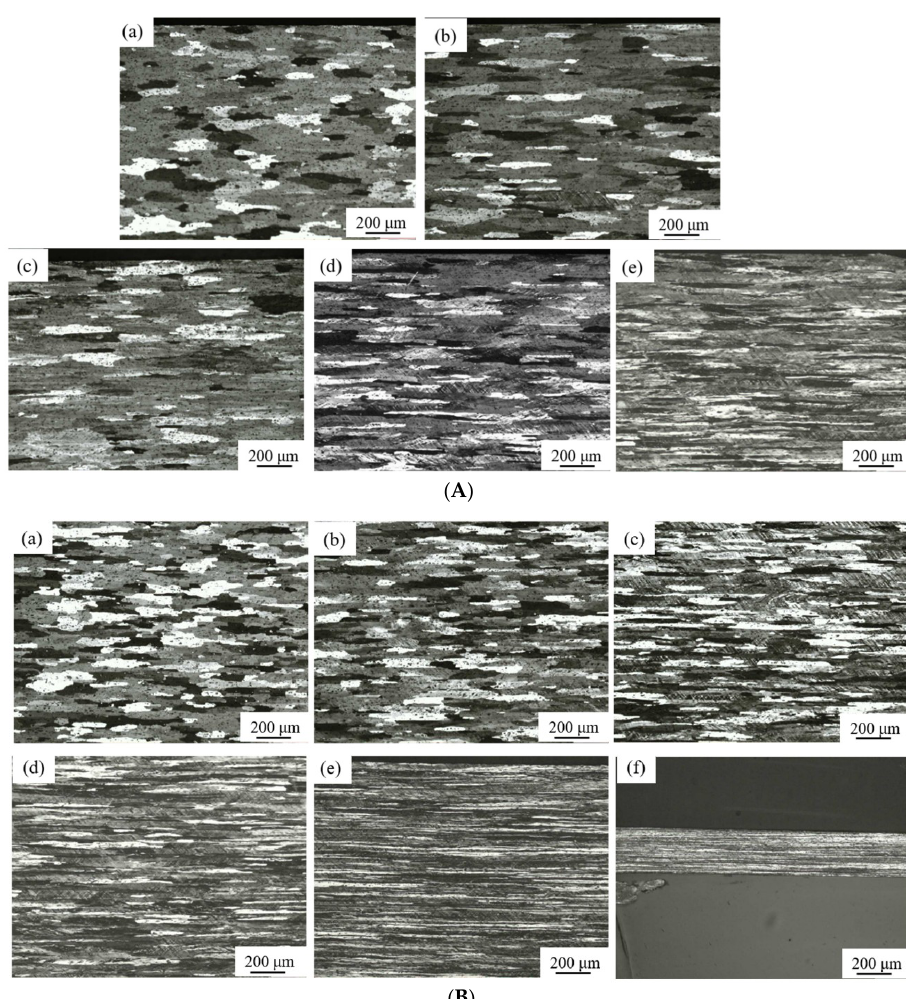
Figure 1. Optical metallographs of the as-annealed and cold-rolled AA6061 alloy; ( A ) surface region, and ( B ) center portion; ( a ) as-annealed, ( b ) Δt/t 0 = 10%, ( c ) Δt/t 0 = 30%, ( d ) Δt/t 0 = 50%, ( e ) Δt/t 0 = 70%, and ( f ) Δt/t 0 =